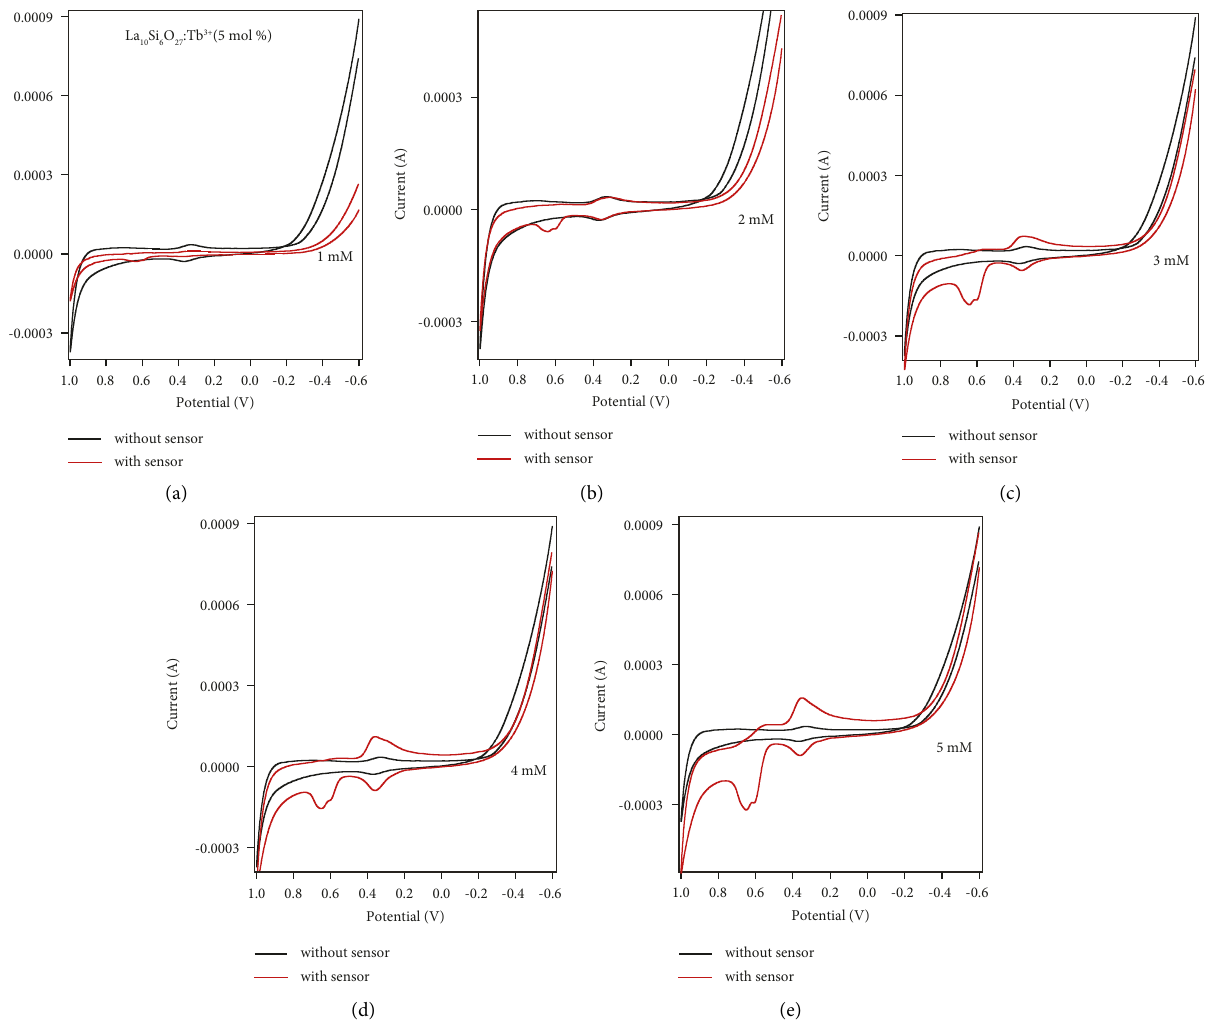
Figure 12: Cyclic voltammogram of La range